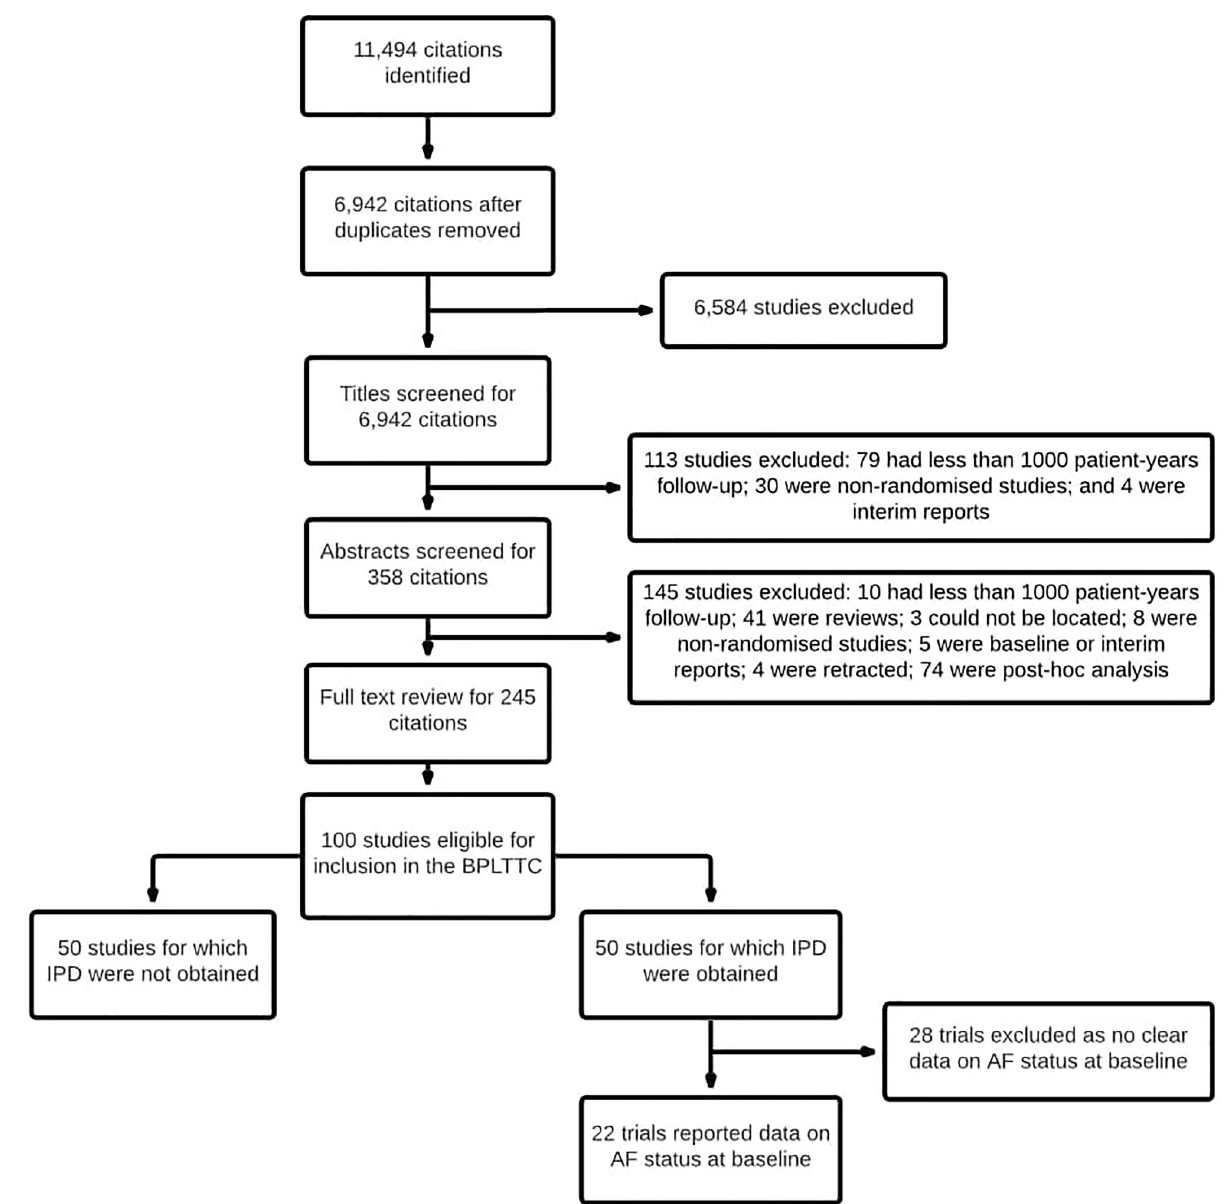
Fig 1. PRISMA diagram for included trials. AF, atrial fibrillation; BPLTTC, Blood Pressure Lowering Treatment Trialists’ Collaboration; IPD, individual participant data; PRISMA, Preferred Reporting Items for Systematic Reviews and Meta-Analyses.